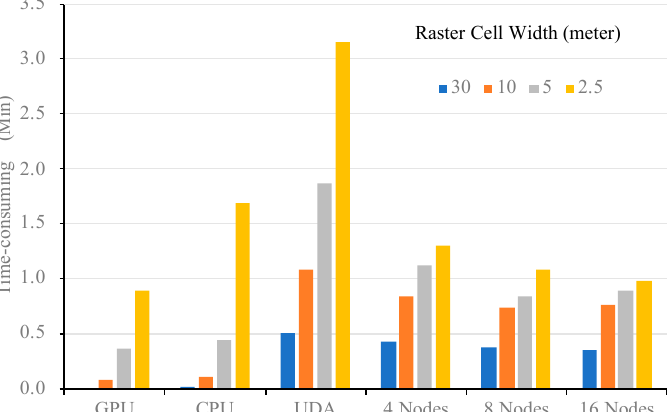
Figure 14. Time-consumption for slope calculation with graphics processing unit (GPU), central processing unit (CPU), unified device architecture (UDA), and different cluster size.